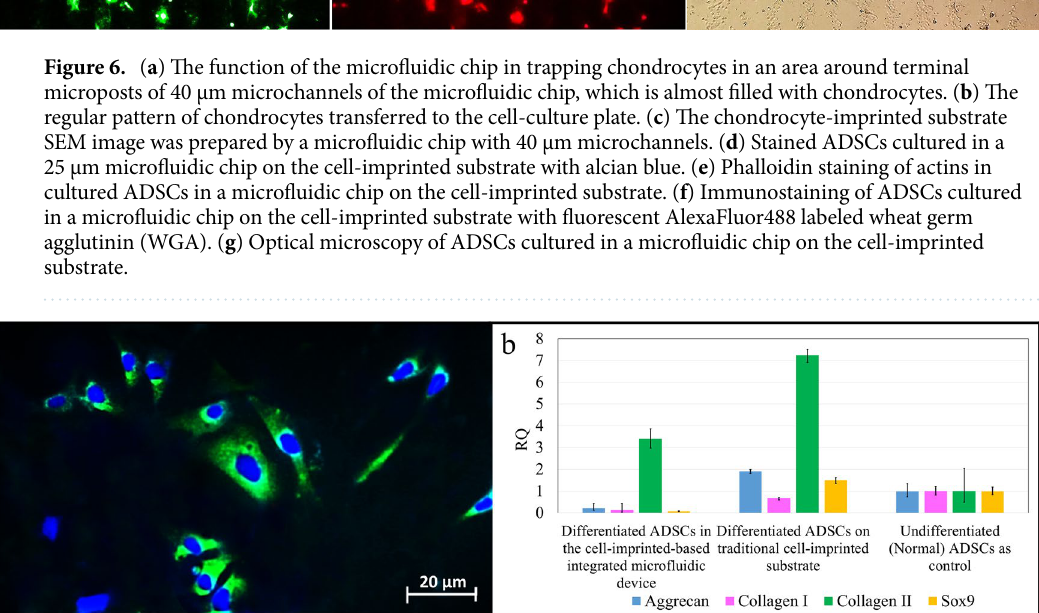
In ADSCs cultured in the cell-imprinted-based integrated microfluidic device compared with cultured ADSCs on the traditional cell-imprinted substrate, collagen II expression (a chondrocyte specific gene marker) is up- regulated while the expression of collagen I is significantly down-regulated. As a criterion for comparison between chondrogenic differentiations in different methods, the ratio of colla- gen type II to collagen type I expressions was evaluated for cultured ADSCs in the cell-imprinted-based integrated microfluidic device and on the traditional cell-imprinted substrate. According to Fig. 7b, this ratio is significantly higher for differentiation of ADSCs in the cell-imprinted-based integrated microfluidic device (3.39/0.137 ~ 24.7) than the traditional cell-imprinted substrate (7.23/0.68 ~ 10.6).